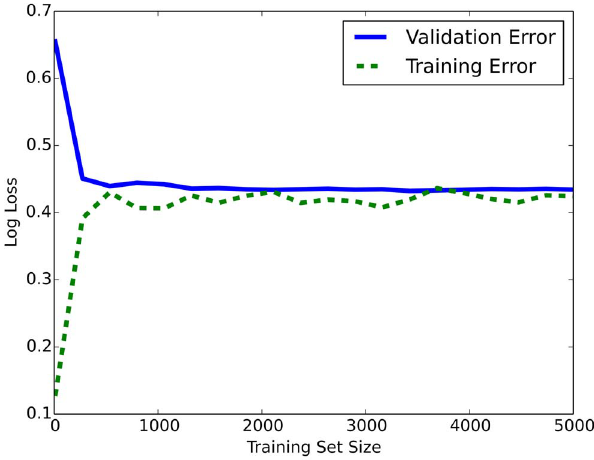
Figure 6. Learning curve for logistic regression with log loss metric. The training error and validation error converges by the time the dataset reaches the size of 1000 author pairs. Therefore the training set size (5361 positive instances and 5361 negative instances) is sufficient for the task.